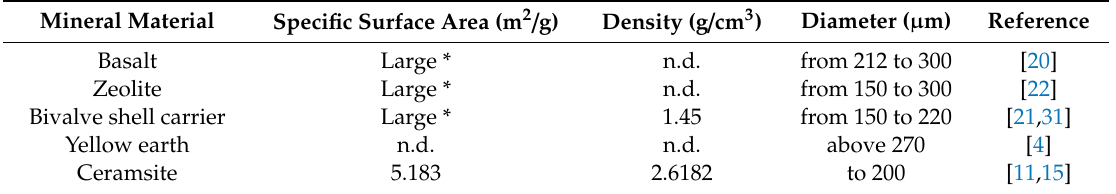
Table 1. Physical properties of powdered mineral materials used in previous aerobic granular sludge (AGS) research. Mineral Material Specific Surface Area (m 2 / g) Density (g / cm 3 ) Diameter ( µ m) Reference Basalt Large * n.d. from 212 to 300 [20] Zeolite Large * n.d. from 150 to 300 [22] Bivalve shell carrier Large * 1.45 from 150 to 220 [21,31] Yellow earth n.d. n.d. above 270 [4] Ceramsite 5.183 2.6182 to 200